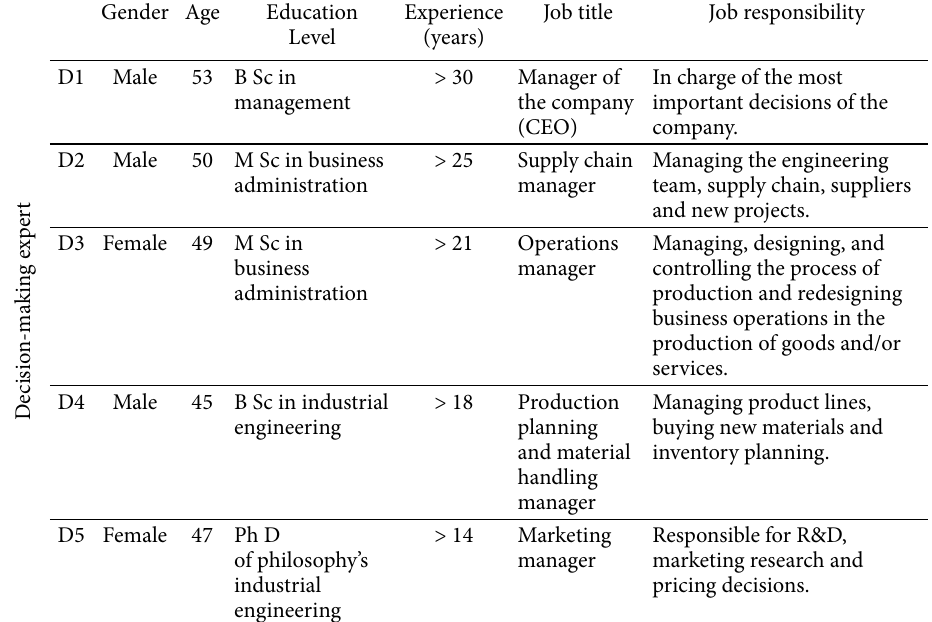
Table 2. The characteristics of the five decision-making